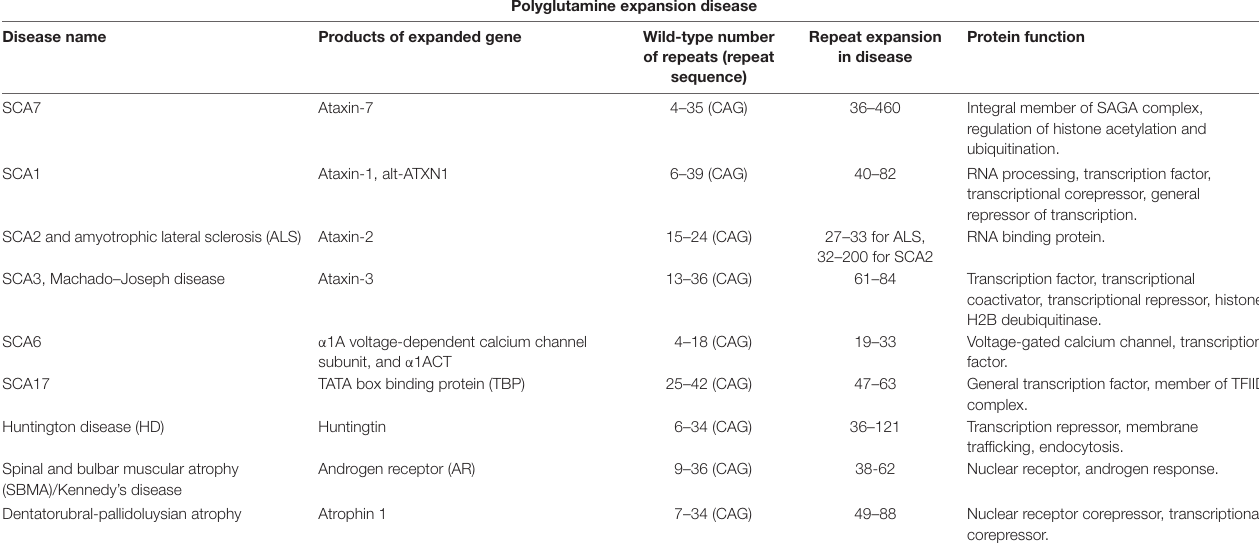
TABLE 1 | Summary of polyglutamine